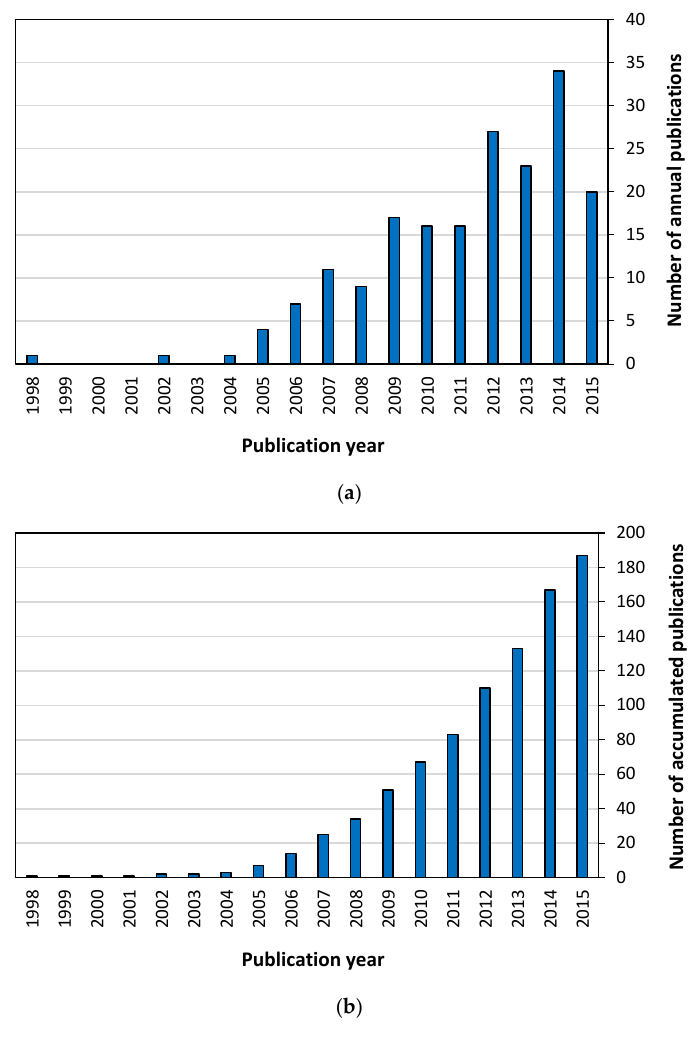
Figure 2. ( a ) Annual and ( b ) accumulated publication output.